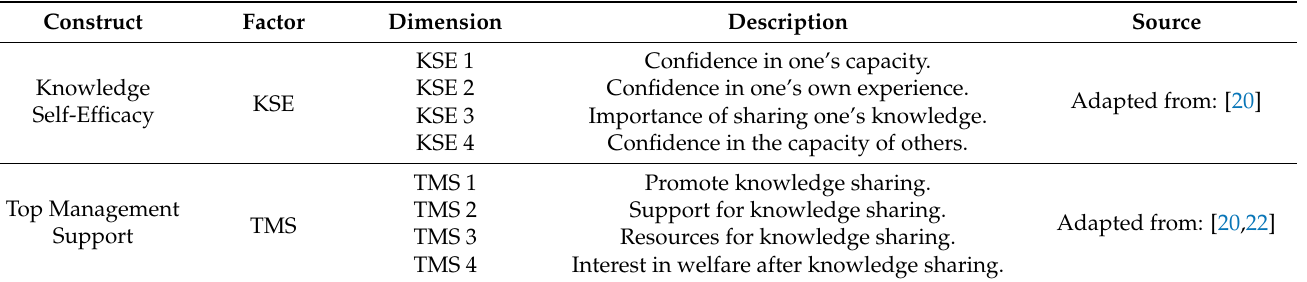
Table A1. Measurement Scales Developed by the